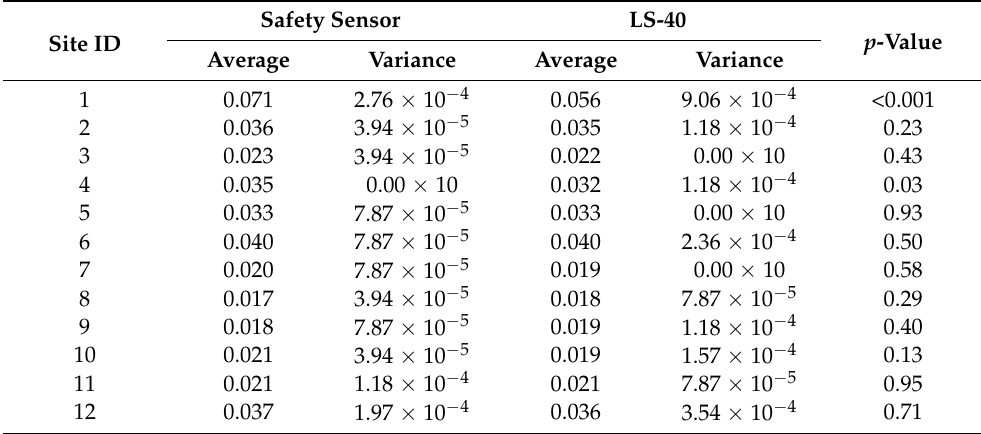
Table 1. ANOVA test results of